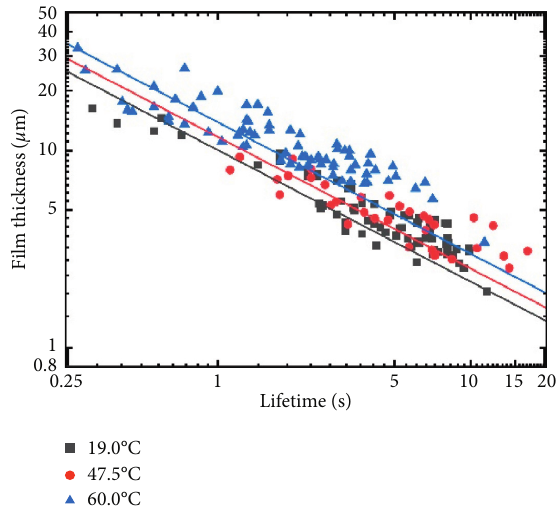
Figure 15: Curve fitting at different liquid temperatures.